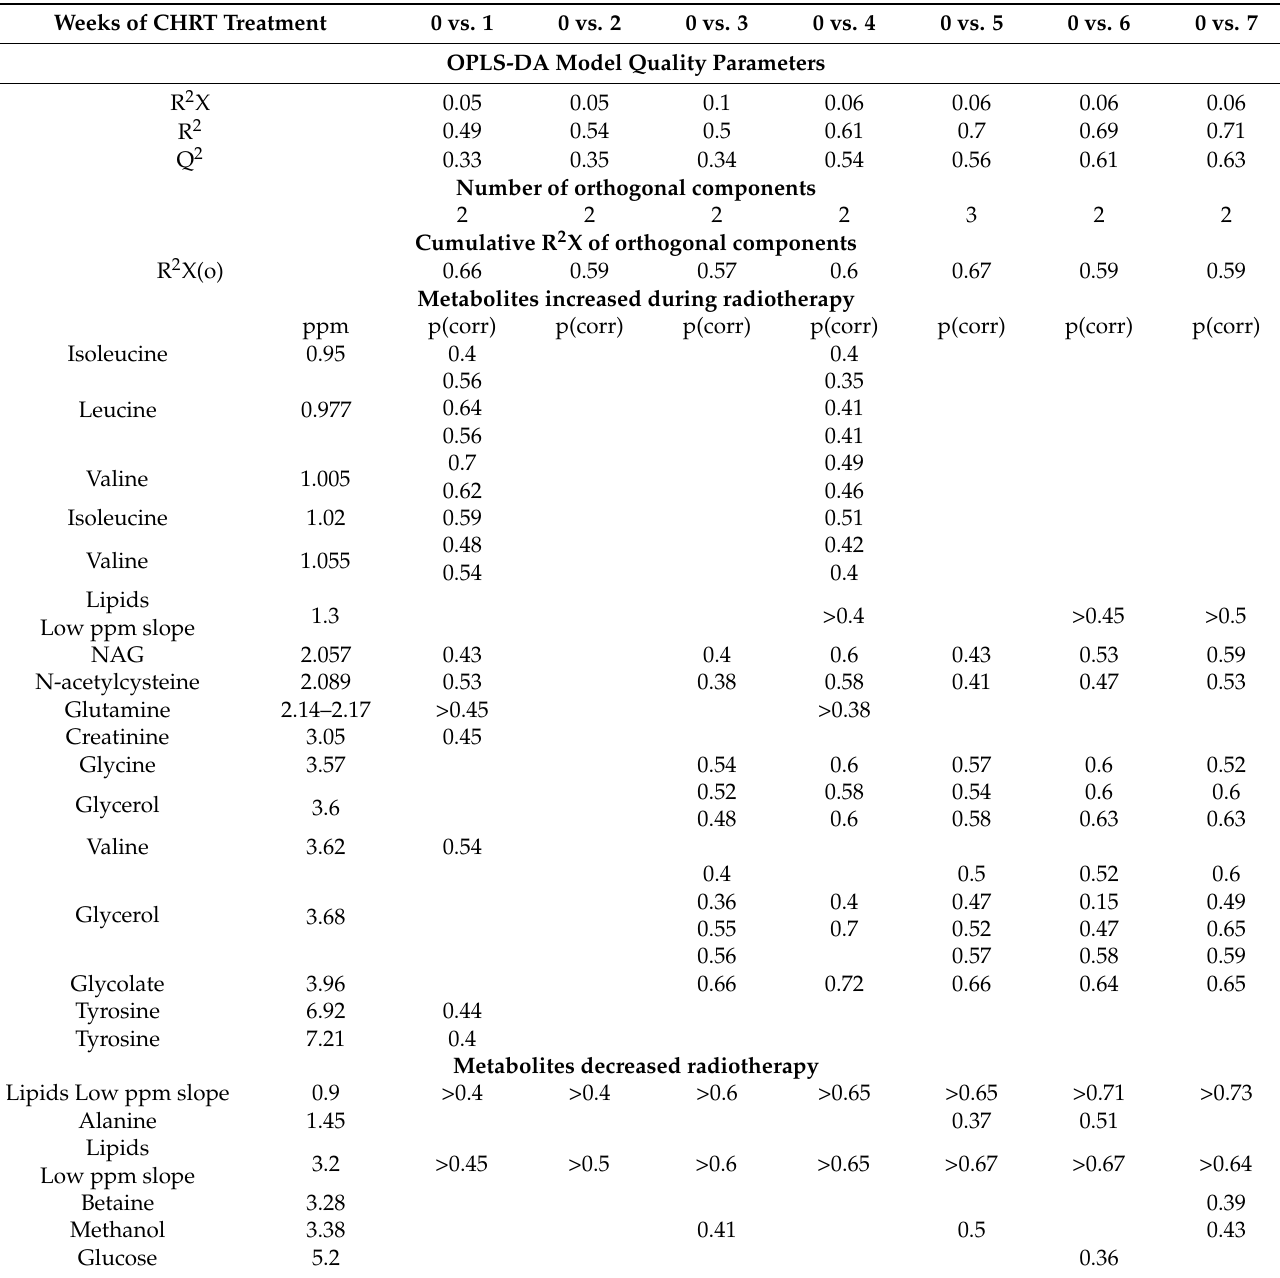
Table 1. Results from the OPLS-DA analysis of the blood serum metabolic profile changes occurring during concurrent chemoradiotherapy